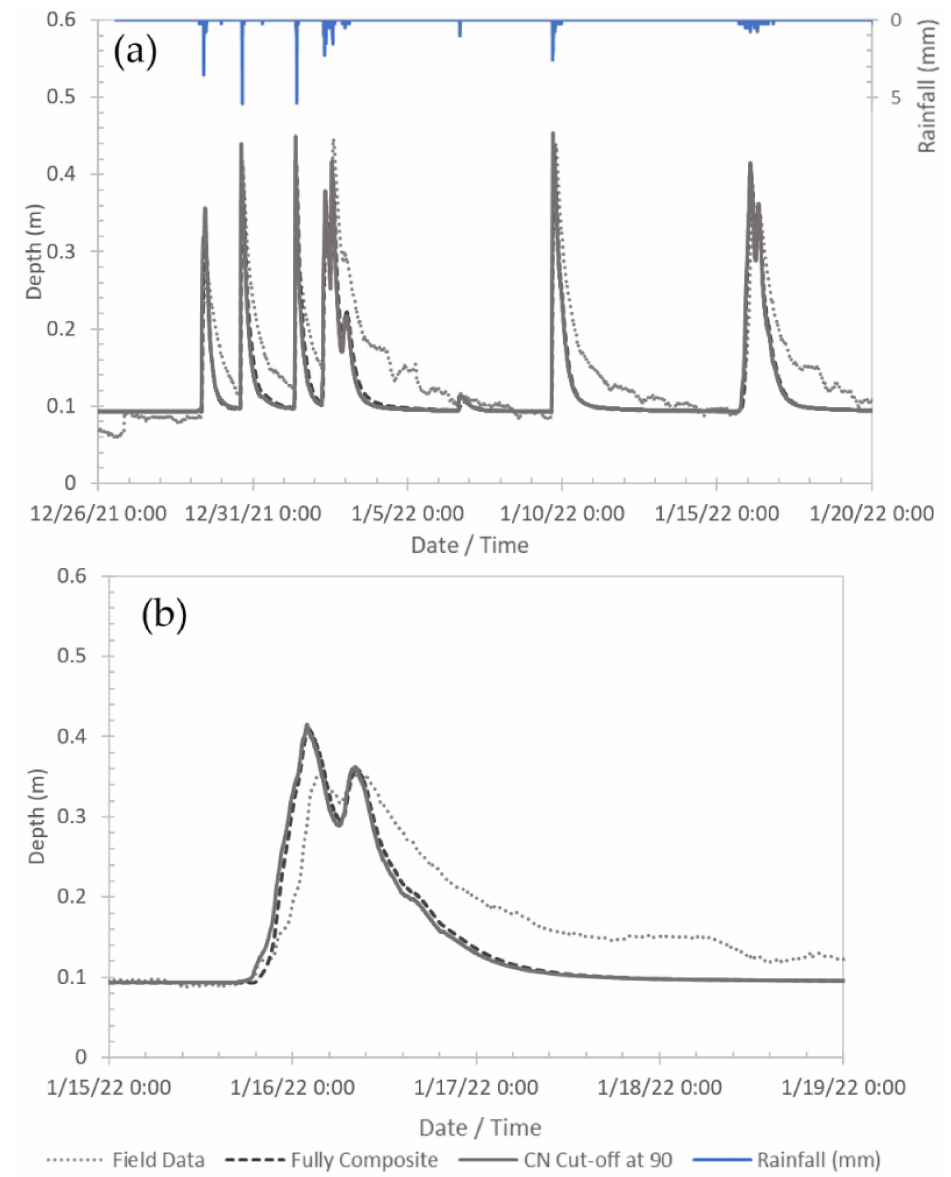
Figure 8. ( a ) Bent Creek Road depth hydrograph and hyetograph with corresponding modeling results; ( b ) Detail of the depth hydrograph for the rain event on 16 January